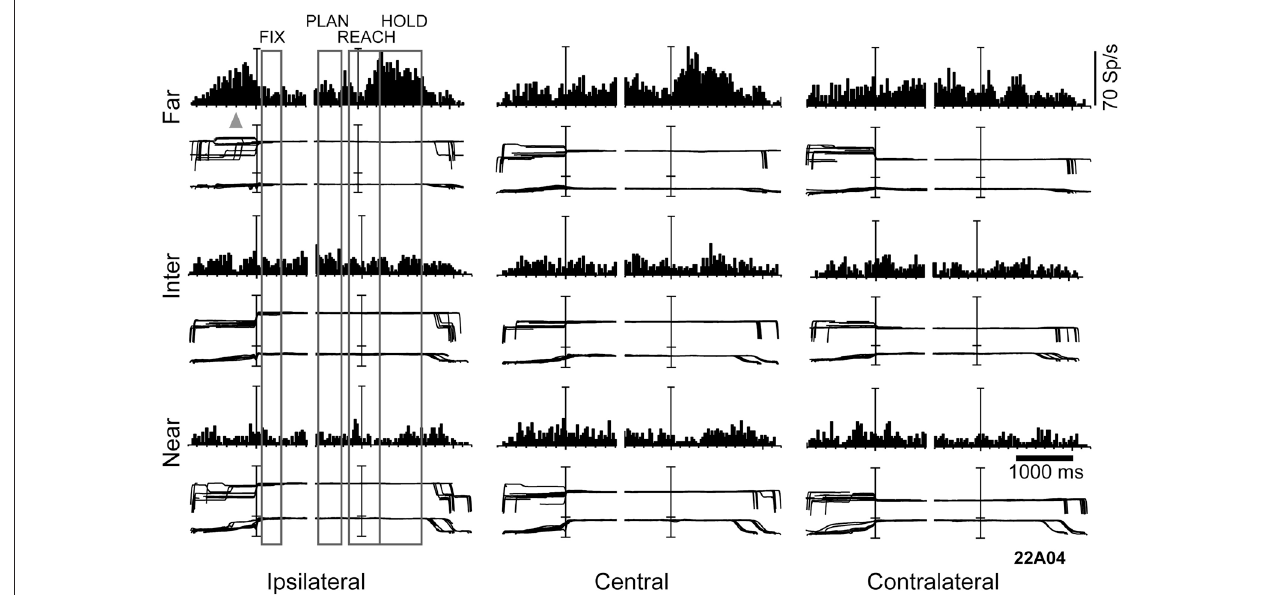
FIGURE 3 | Example of a V6A neuron modulated by depth and direction signals during several epochs of a reaching-in-depth task. Target LEDs were arranged as in Figure 2B . Spike histograms and eye traces were aligned twice, at the fixation onset and at the start of movement. This cell prefers far